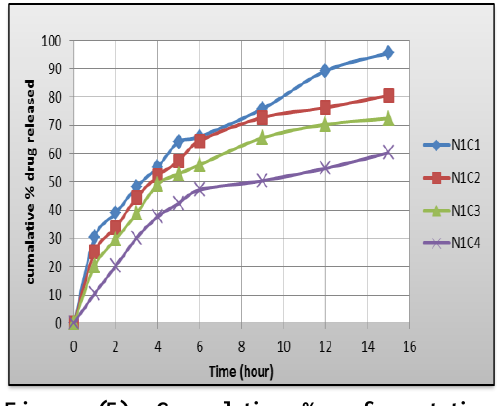
Figure (5): Cumulative % of nystatin released versus